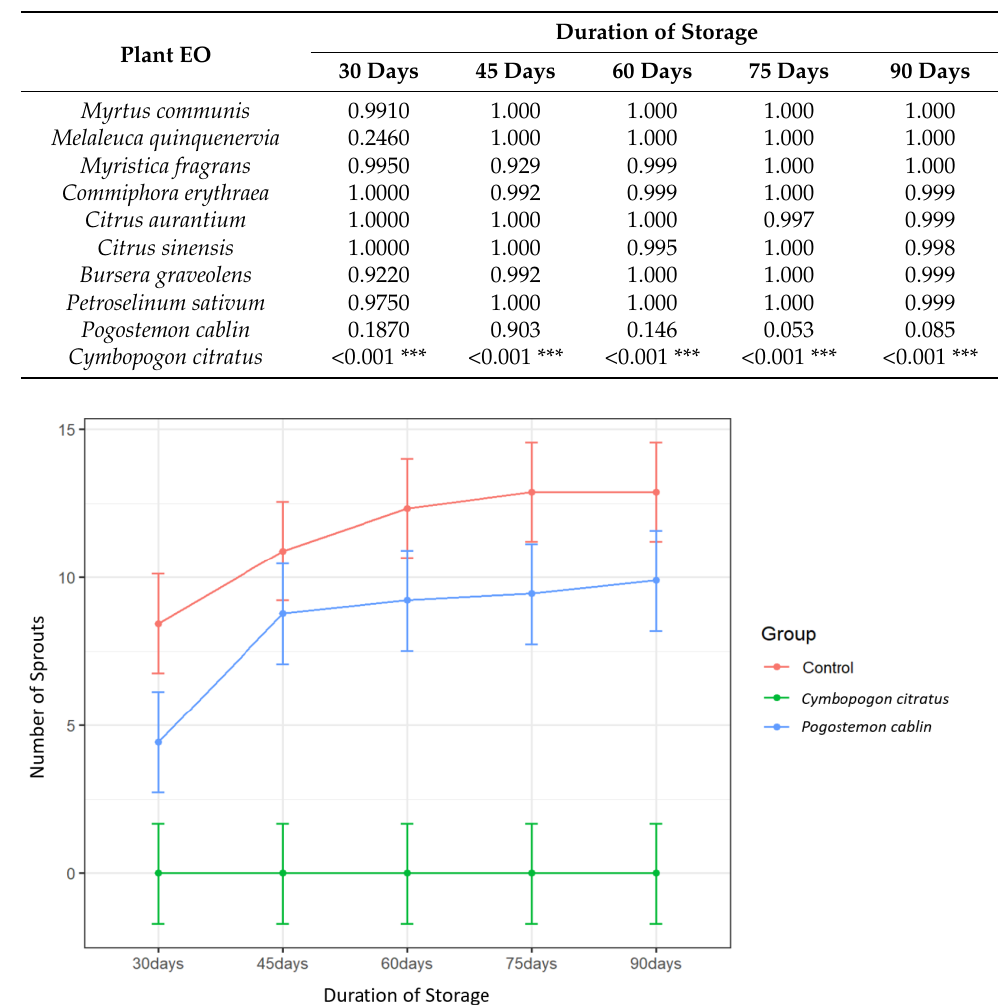
Figure 2. Number of sprouts per tuber over time of potatoes treated with distilled water (control), Cymbopogon citratus , and Pogostemon cablin EOs. Error bars represent the 95% confidence level of the means ( emmeans method ).